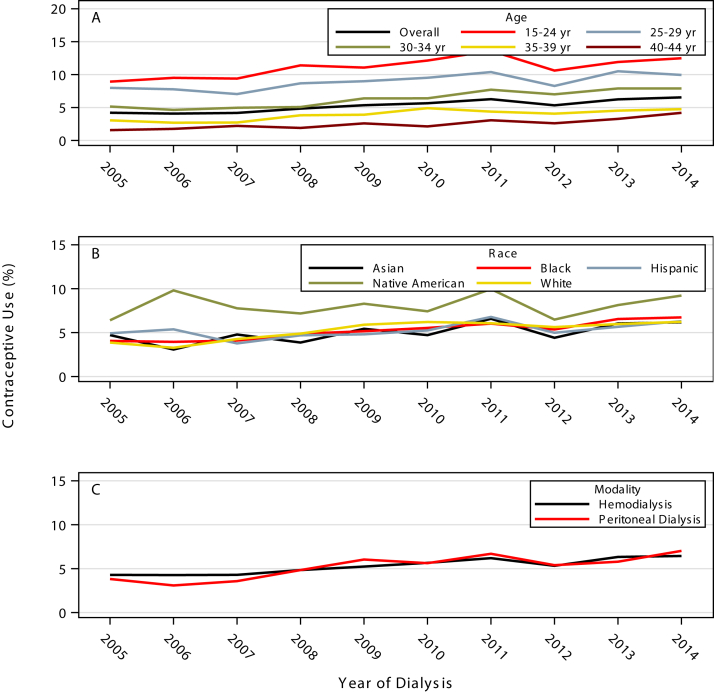
Contraceptive rates in women with end-stage kidney disease by: (A) age, (B) race, and (C) dialysis modality. All 3 graphs show an upward trend from 2005 to 2014. The age graph shows a decline in rates with increasing age. The race graph shows a higher rate among Native Americans as compared with other races. The dialysis modality graph shows similar rates across time from 2005 to 2014.